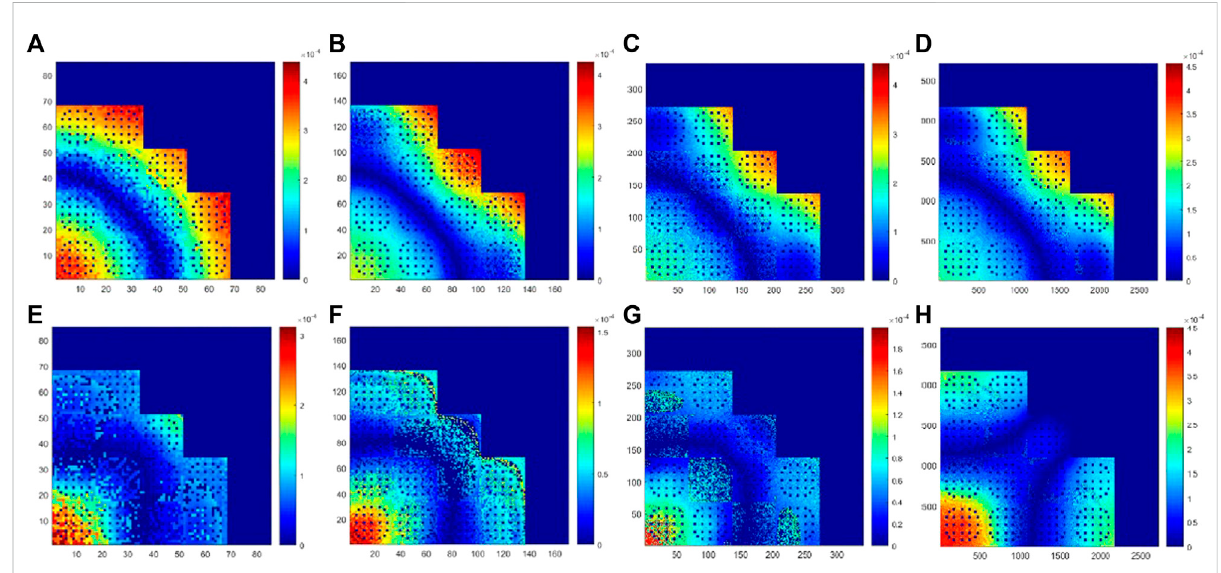
FIGURE 4 Relative error (%) ofpower density betweencomePSn_JFNKand comePSncodeson differentmesh sizes per pinfor 2-D KAIST-3A benchmark